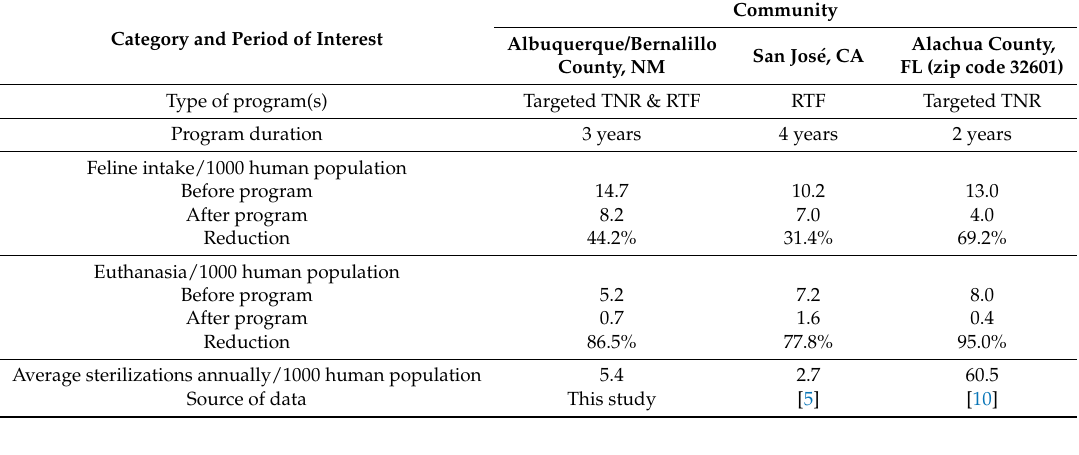
Table 3. Impact of Albuquerque CCP in terms of intake and euthanasia per 1000 human residents, and comparison to similar programs in other communities.